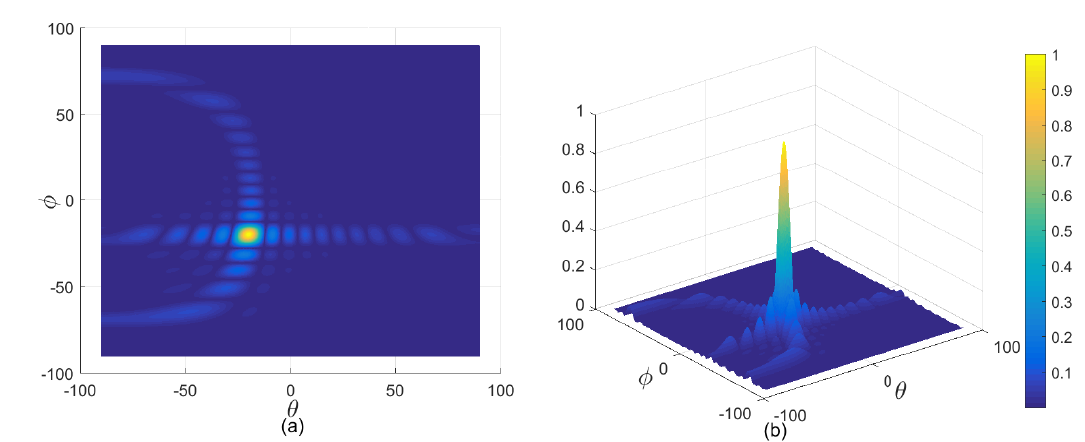
Figure 2. 3D beam pattern diagram, N = M = 16 ( a ) Top view ( b ) 3D perspective view.